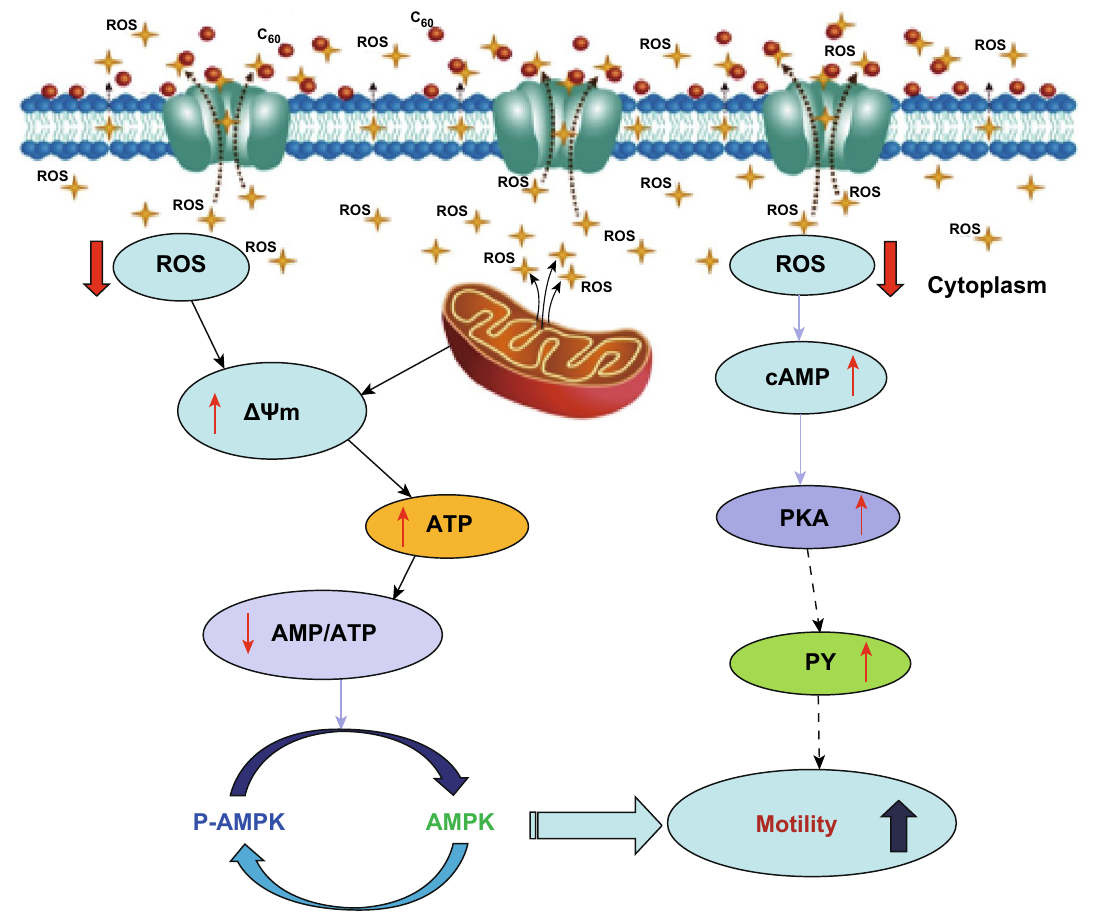
Fig. 9 Putative mechanisms by which carboxylated C 60 protects boar sperm from ROS-induced functional damage at 4 °C. Carboxylated C 60 may bind to ROS outside and reduce ROS levels inside sperm. Decreasing intracellular ROS levels may enhance the mitochondrial membrane potential and cAMP levels and also reduce cellular protein dephosphorylation and enhance cellular ATP levels, subsequently increasing the motility of spermatozoa at 4 °C. Δ ψ m : mitochondrial membrane potential; PKA: protein kinase A; PY: tyrosine